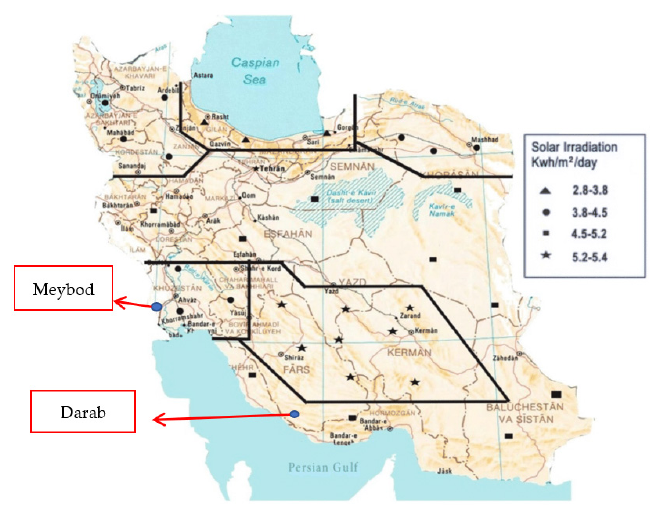
Figure 1. Location of two investigated areas.